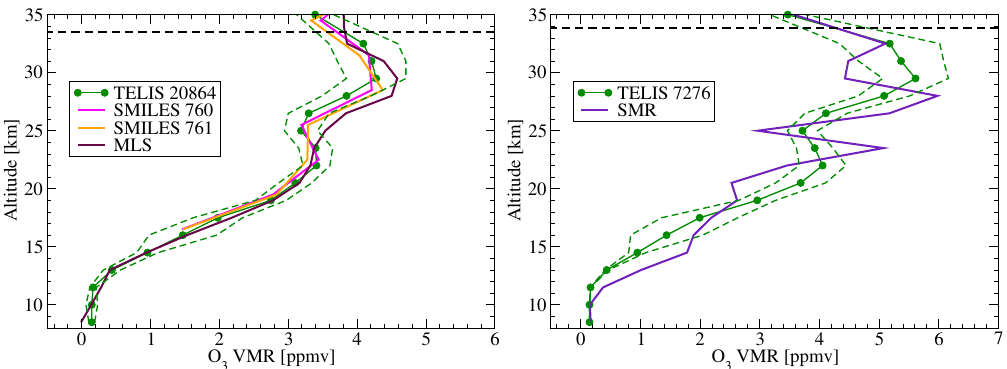
Figure 5. Comparison of O 3 profiles retrieved from TELIS, Superconducting subMIllimeter-wave Limb-Emission Sounder (SMILES), Microwave Limb Sounder (MLS), and Sub-Millimeter Radiometer (SMR) data measured on 24 January 2010. The lowest tangent height of the TELIS instrument is 10km and the retrieval results below this altitude have little physical meaning. The dashed green lines refer to the overall accuracy of the TELIS profile. The measuring time difference of all plotted profiles was within 0.5h. The solar zenith angles of the MLS and TELIS data were 84.0 ◦ and 85.8 ◦ ,